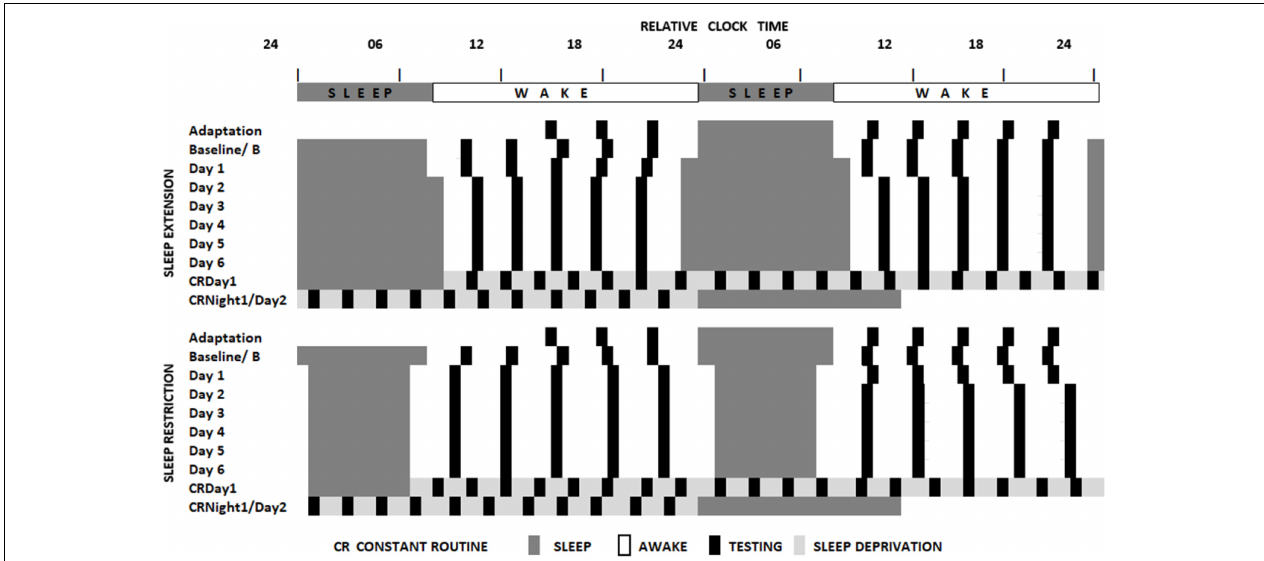
FIGURE 1 | Schematic representation of the sleep restriction-sleep extension protocol. All participants completed two sleep opportunity condition sessions. In both sessions, participants were scheduled to sleep at their habitual times for two consecutive nights and then to extended (10 h) or restricted (6 h) sleep opportunities